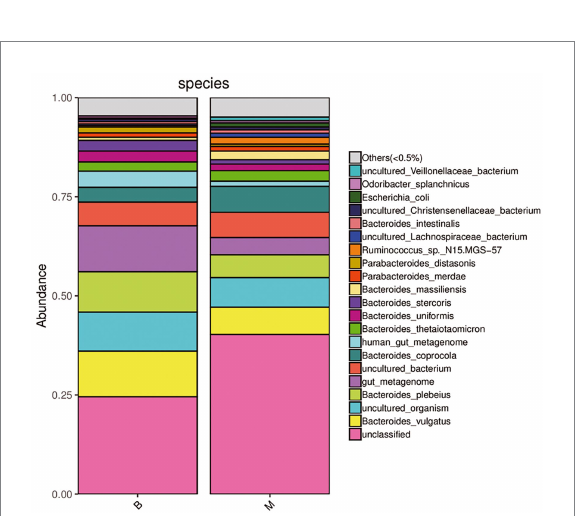
FIGURE 5 Histogram of species distribution of bacterial microbiota in Group M and Group B. Species level. Under the existing detection and identification methods, the microbial strain (pink) that could not be annotated in the gut microbiota in Group M was significantly higher than that in Group B. The overall abundance of the dominant bacterial microbiota such as Bacteroides vulgatus (yellow), B. plebeius (light green), B. coprocola (dark green) belonging to Bacteroidetes in Group M was also different from that in Group B.